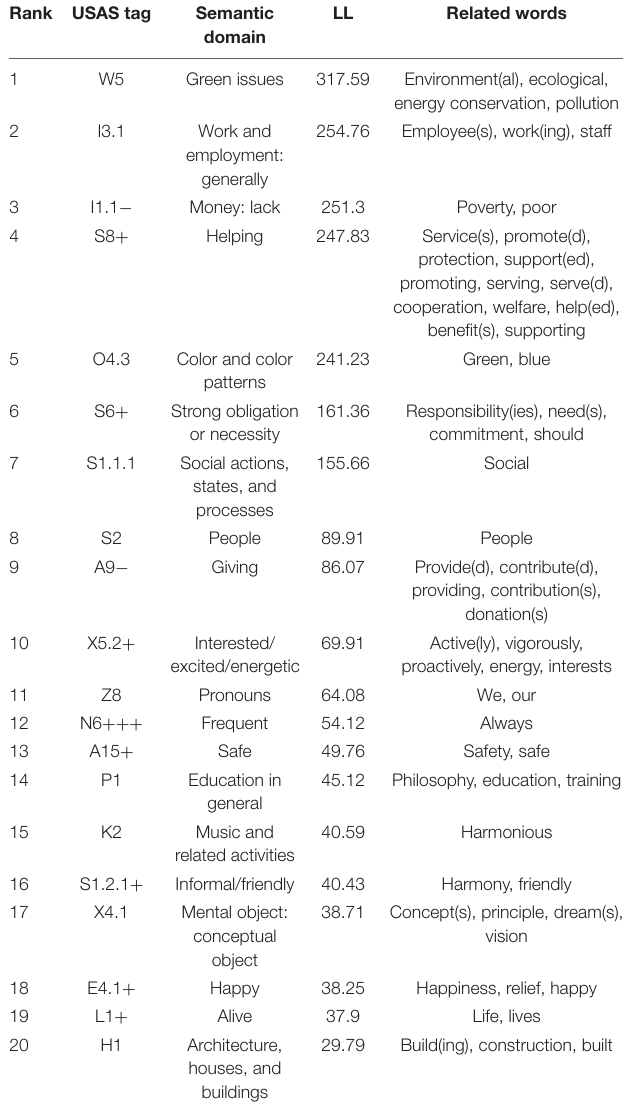
TABLE 5 | Top 20 key semantic domains in the CSR report CEO